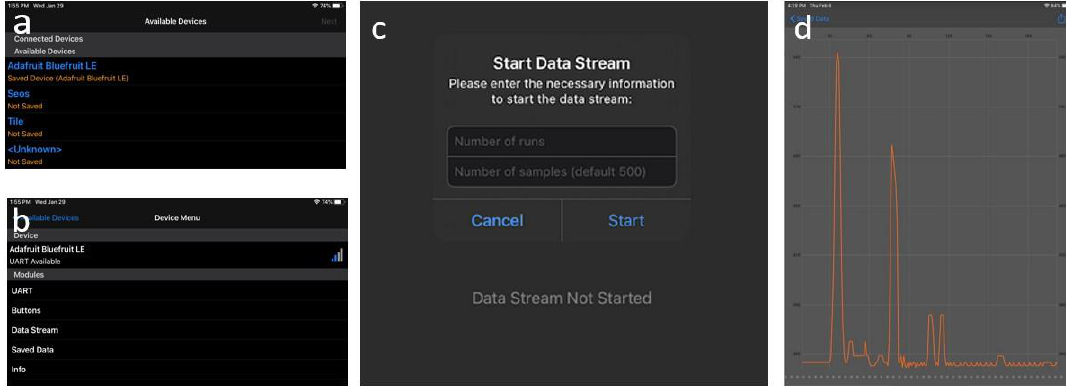
Figure 7. Screenshots of the custom application for mobile devices such as tablets and phones. ( a ) Panel to select the appropriate module from a list of devices. ( b ) Panel to select a data stream from a device menu. ( c ) Panel to enable the user to select the desired number of samples and runs. ( d ) Display of a single measurement from a sheet of aluminum plotted on the mobile device.